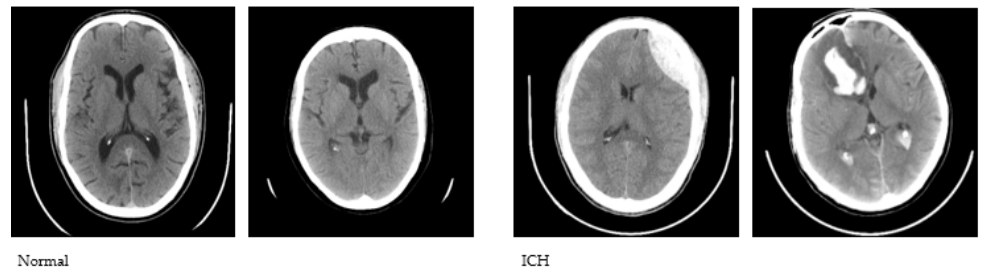
Figure 1. Sample CT images used to conduct the study.